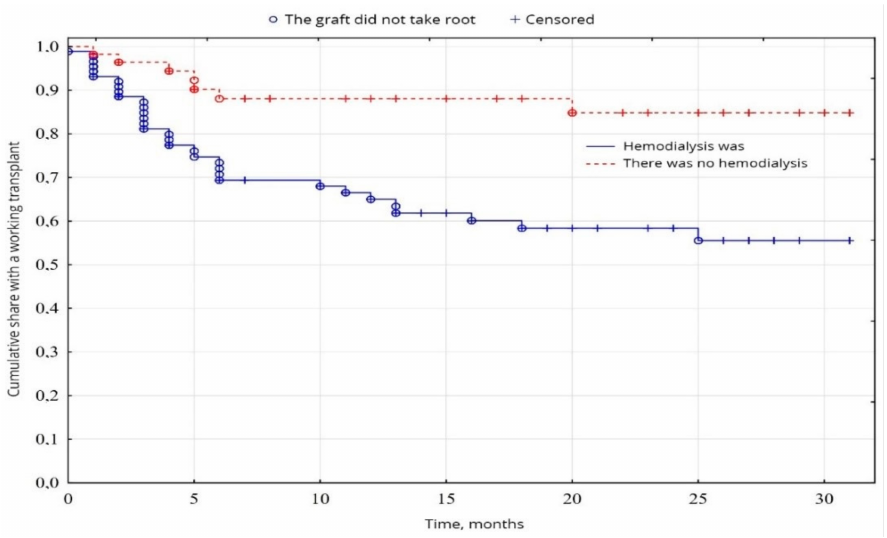
Figure 3. Evaluation of graft function depending on the presence of